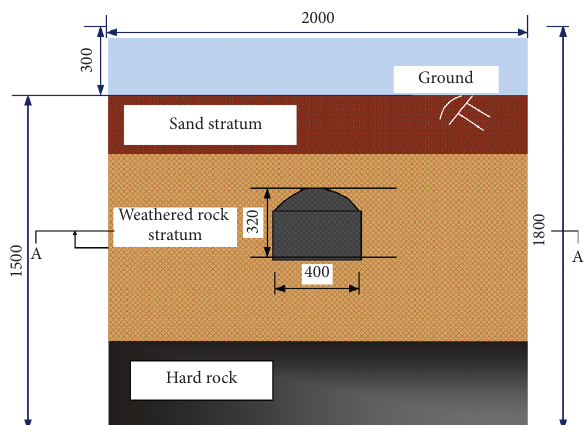
Figure 2: Model size and excavation hole distribution (unit: mm).